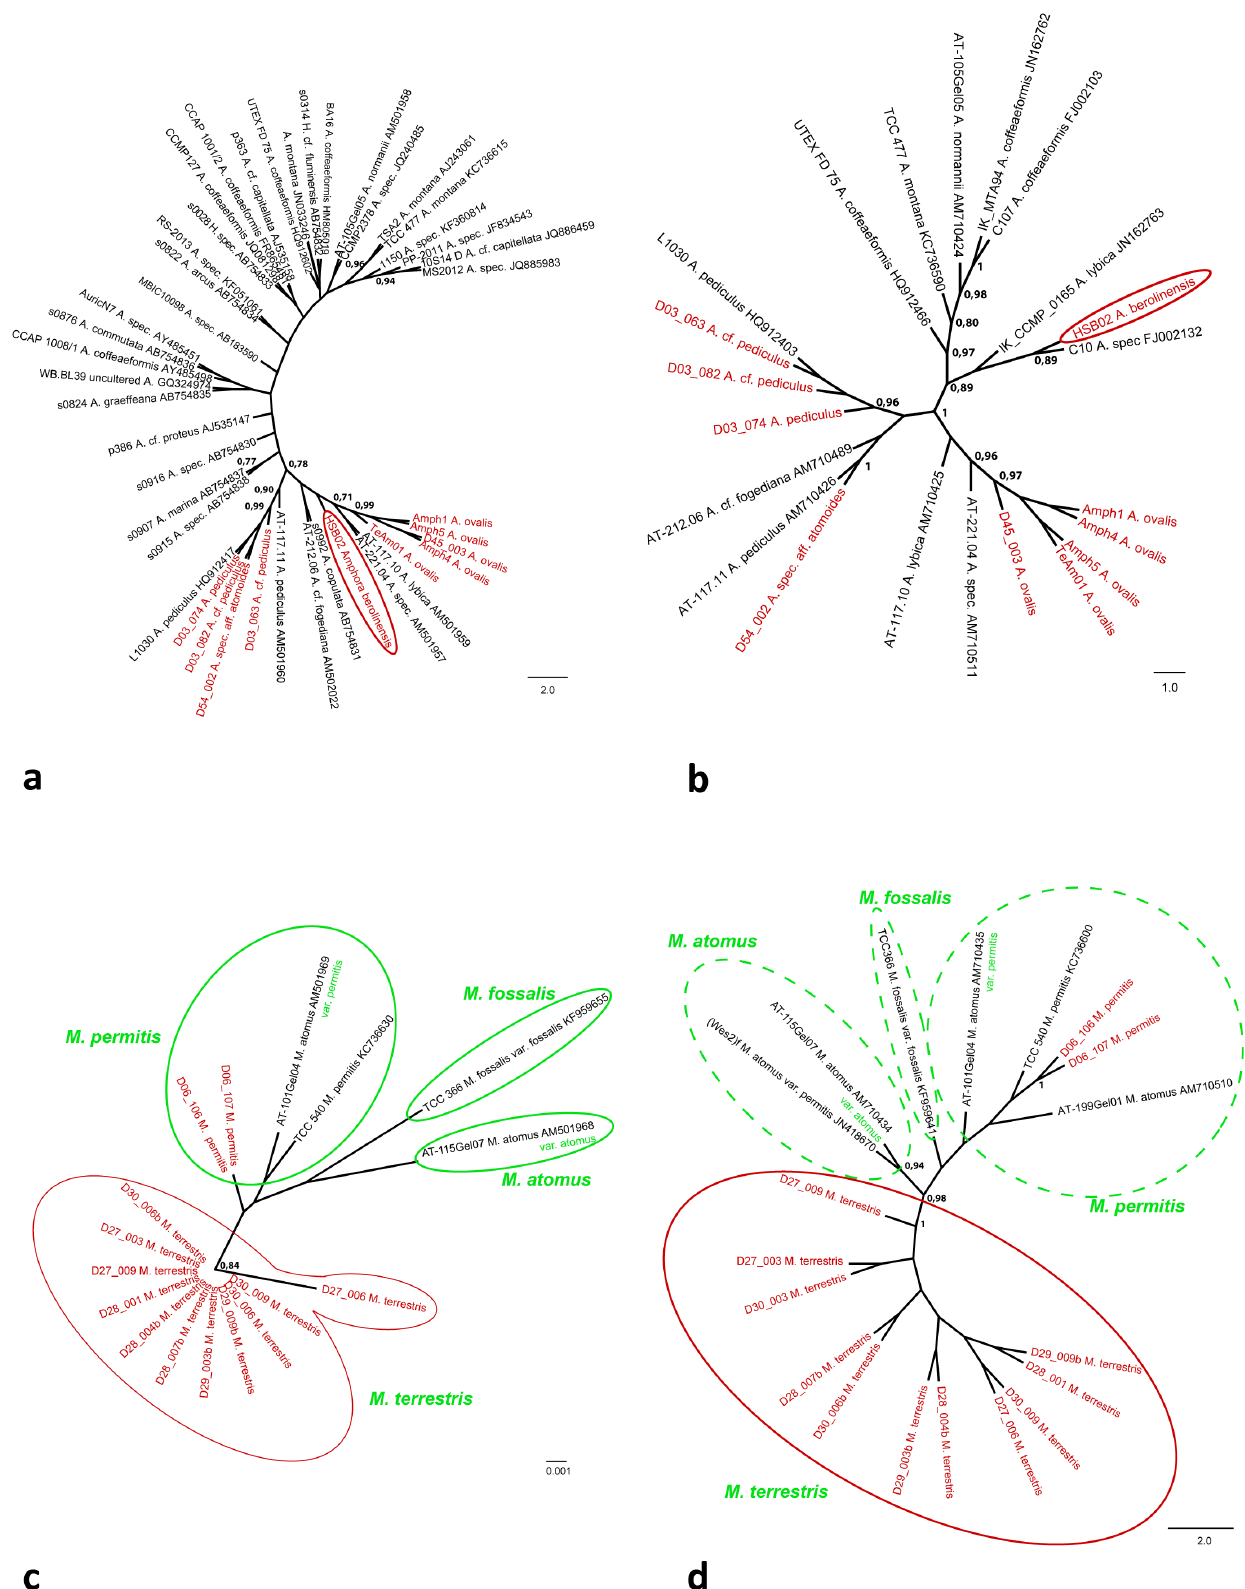
Figure 7. Neighbour Joining Tree (10 000 bootstrap replicates) including all sequences available from the INSDC databases for genus Amphora (a) 18S V4, (b) rbc L as well as Mayamaea (c) 18S V4, (d) rbc L. Bootstrap support values . 0.75 given at nodes. Red indicates data from new species, green information and conlusions derived from data in the AlgaTerra Information System [30]. doi:10.1371/journal.pone.0108793.g007 PLOS ONE |